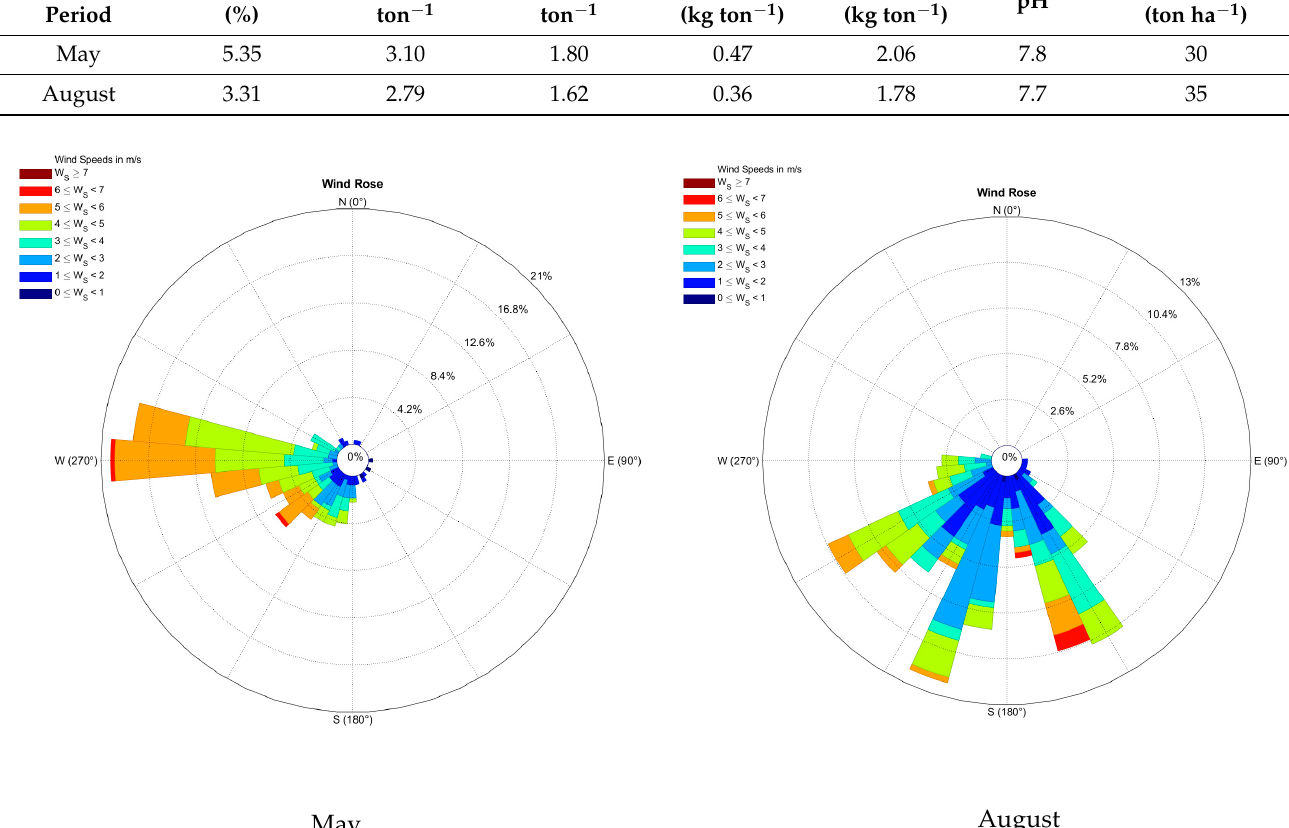
Figure 2. Wind direction and speed for the measurement campaigns in May ( left ) and August ( right ).